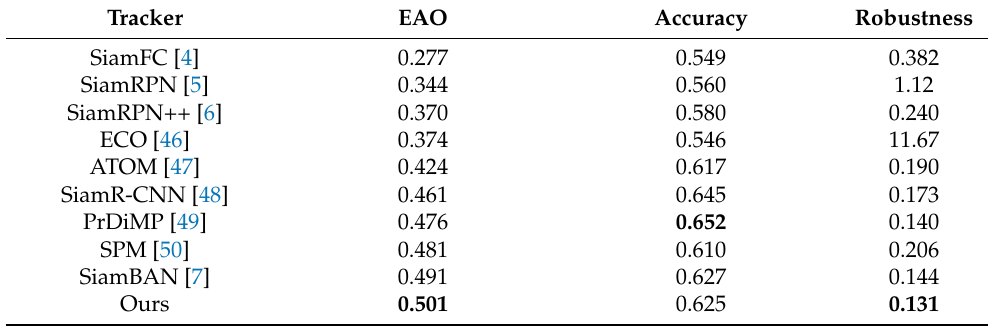
Table 1. Tracking results on VOT2016